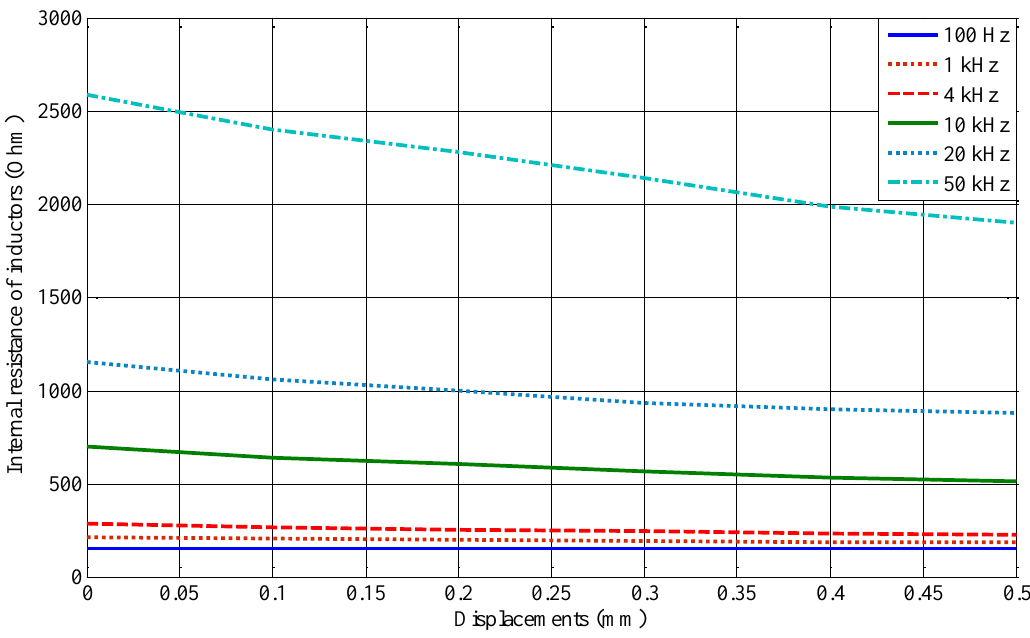
Figure 7. Characteristic of the internal resistance versus the